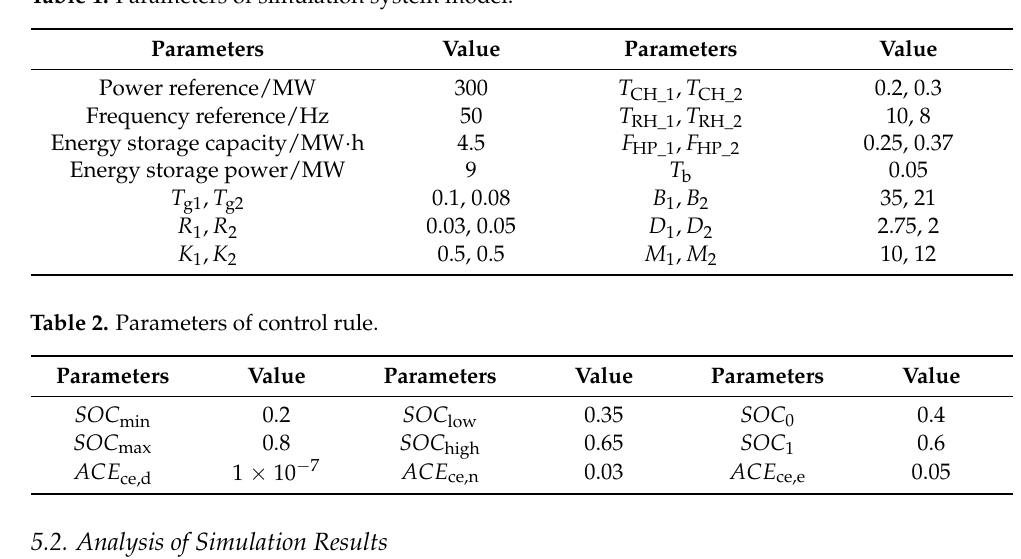
Table 1. Parameters of simulation system model.